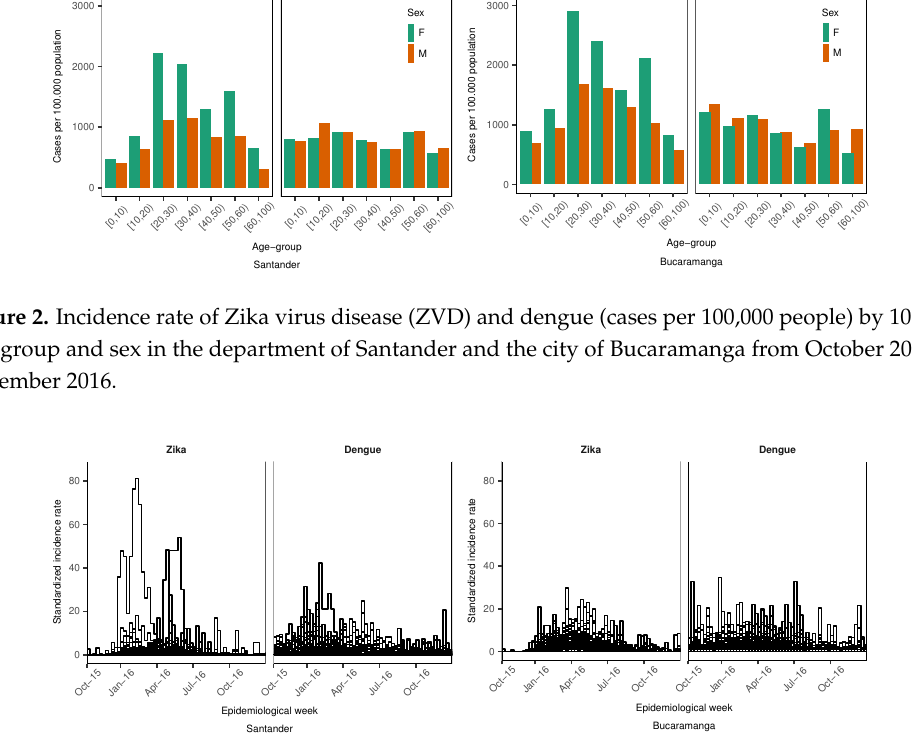
Figure 3. Longitudinal profiles of the standardized incidence ratio (SIR) of dengue and Zika virus disease (ZVD) by municipality (department of Santander) and census sector (city of Bucaramanga) from October 2015 to December 2016.